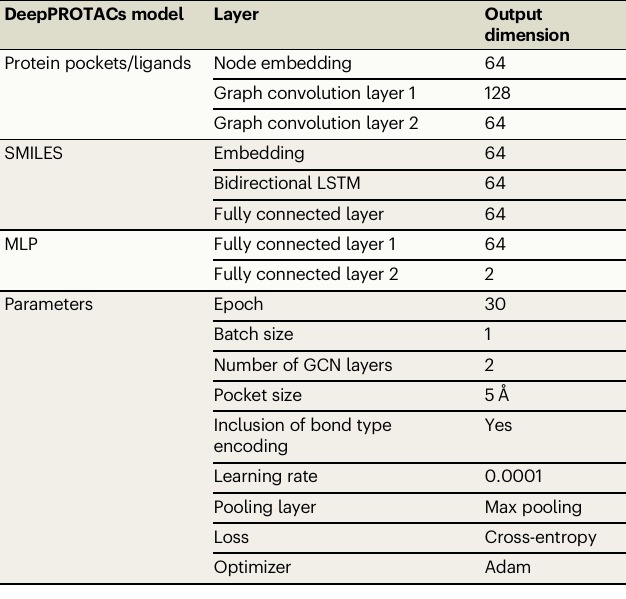
Table 1 | The dimensions and parameters of DeepPROTACs model DeepPROTACs model